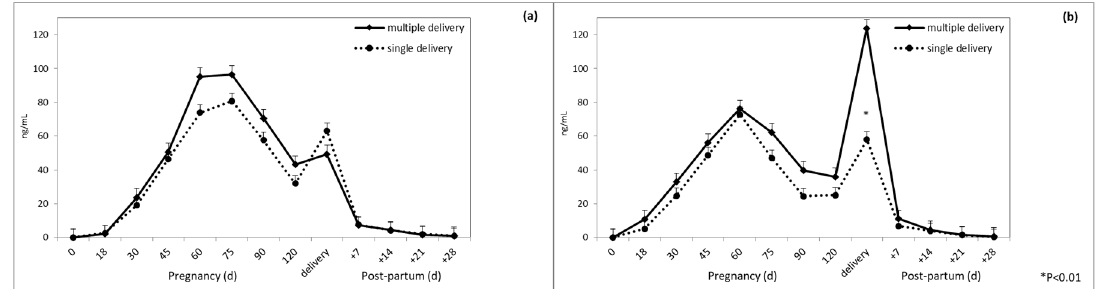
Figure 2. Plasma PAG profile in multiple and single pregnancy at delivery in Sarda ewes when using ( a ) RIA-706 and ( b ) RIA-srPool.